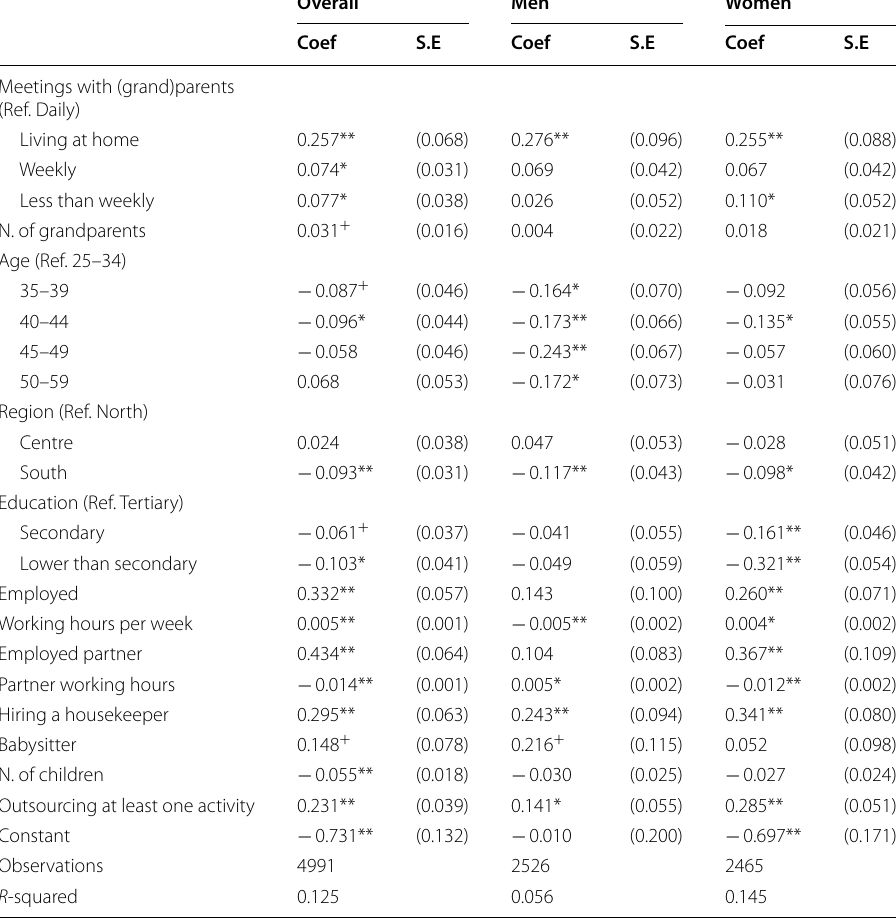
Table 6 Linear regression models on symmetry in the division of routine and instrumental housework tasks (5 items) ( Z